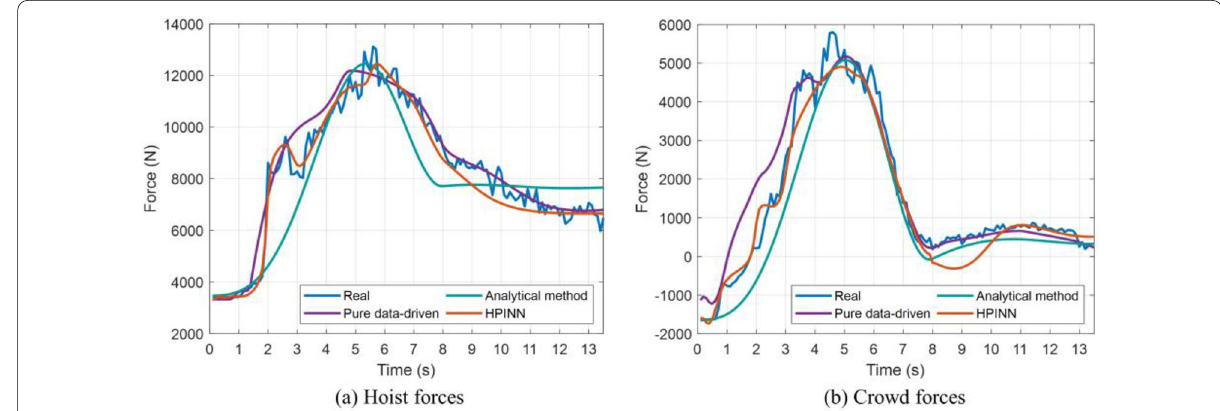
Figure 15 The digging forces predicted by three models on real-world data